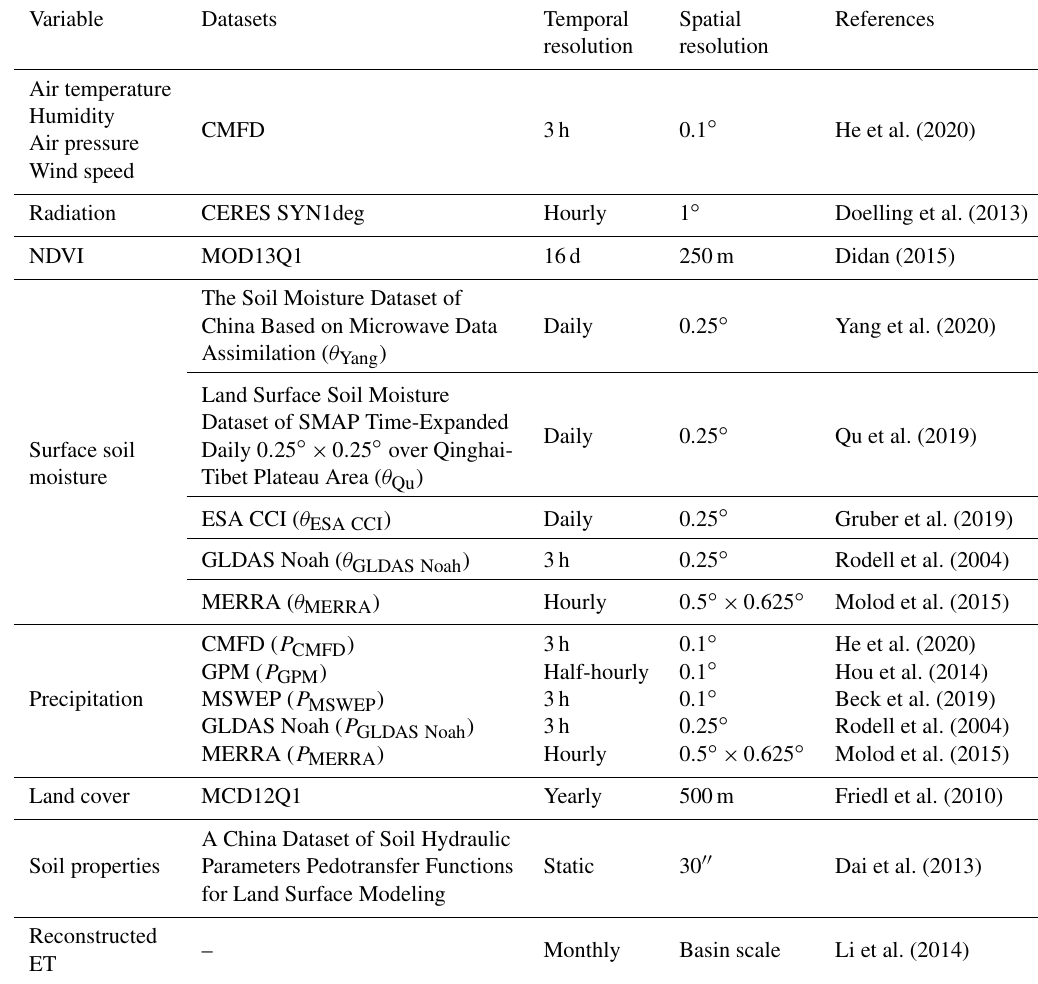
Table 1. List of the forcing datasets used in this study with their original resolutions and